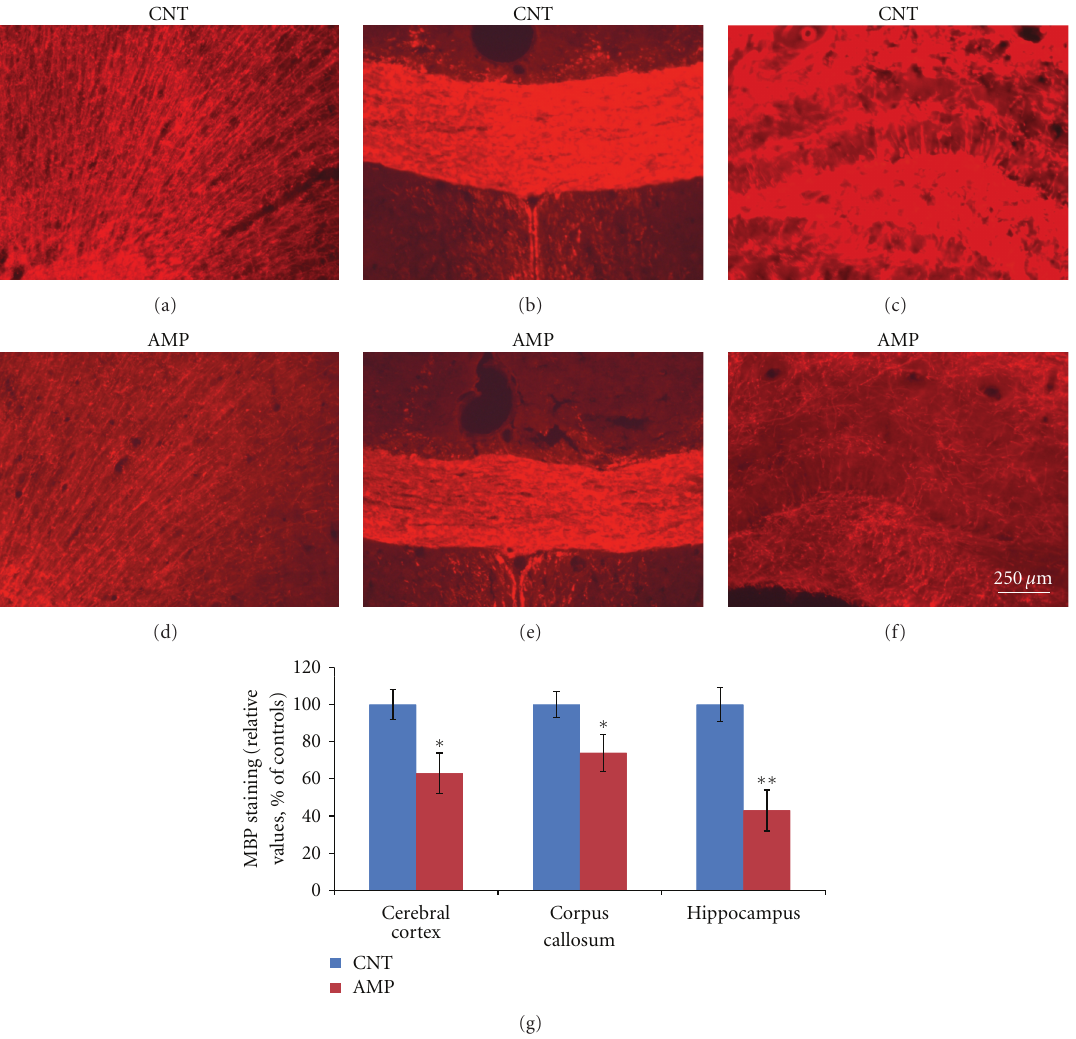
Figure 6: AMP reduced the MBP immune-fluorescent staining in cerebral cortex, corpus callosum and hippocampus. After treating with d-AMP or a same volume of saline for 21 days and subjected to behavioral tests, mice were sacrificed, and their brains were processed for MBP immune-fluorescent staining. Representative photographs were presented and labeled. Quantitative data were statistically analyzed and presented in a bar chart. All AMP-treated mice had decreased values of MBP staining than the average of CNT group. Data were expressed as means ± SEM. Comparisons were made between CNT and AMP groups. ∗ P < 0 . 05; ∗∗ P < 0 .